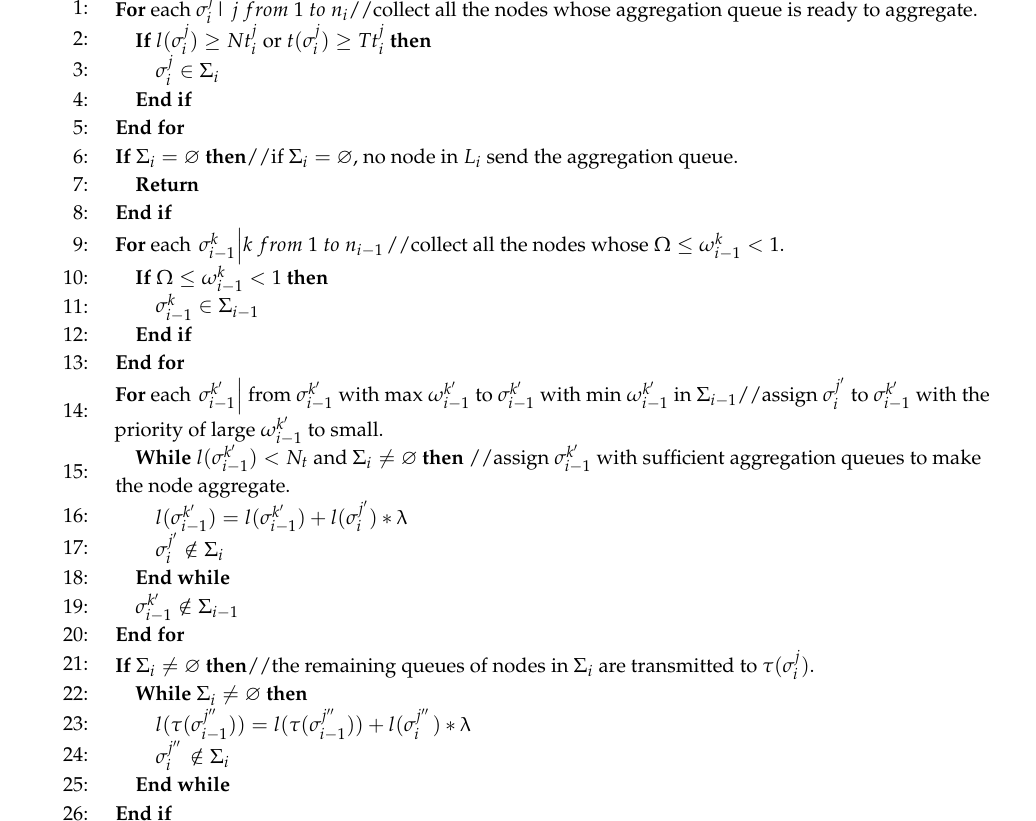
Algorithm 1 Node assignment